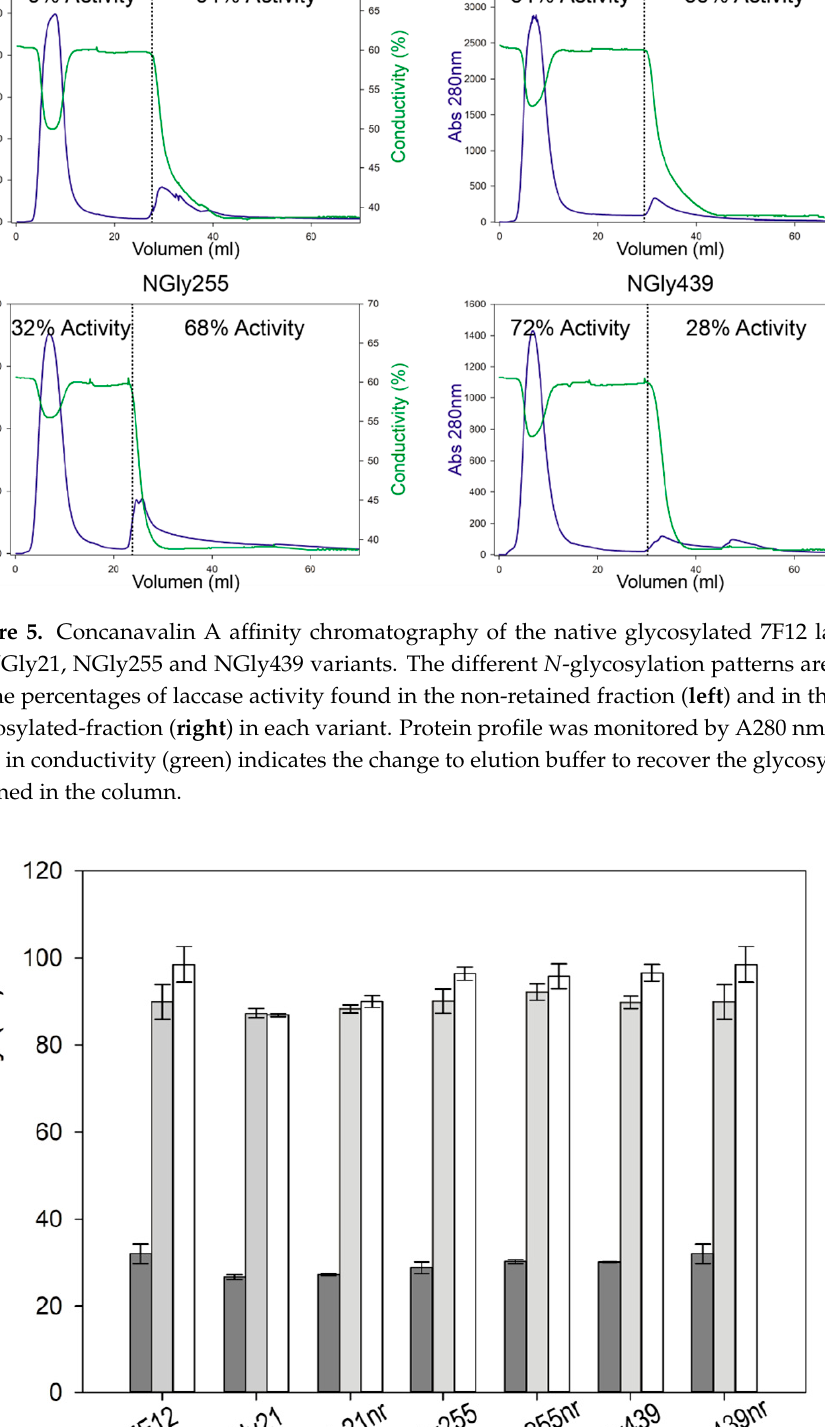
Figure 6. pH stability of parent laccase (7F12) and its NGly variants separated into their retained and non-retained (nr) fractions; Assay was carried out at pH 5 (dark grey bars), 7 (light grey bars) and 9 (white bars); residual activities after 24 h were measured with ABTS pH 3.